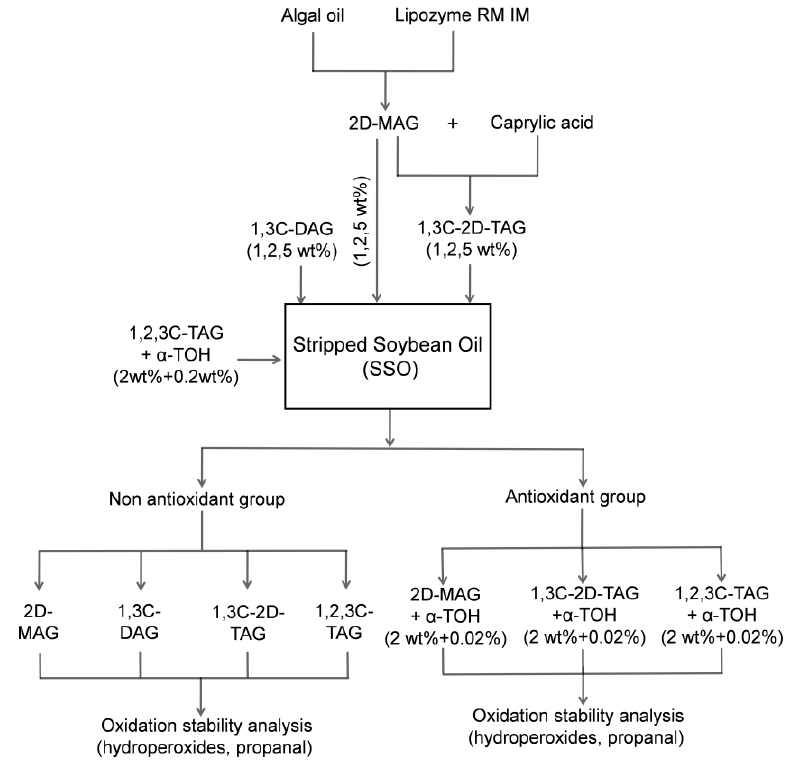
Figure 1. The experimental scheme for oxidative stability of stripped soybean oil with structured lipids.